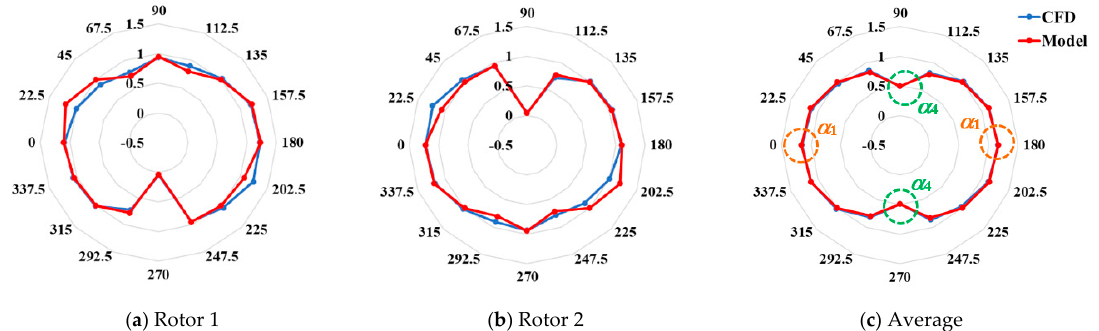
Figure 11. Distributions of normalized rotor powers in the CO-configuration in the case of gap = 1.0 D